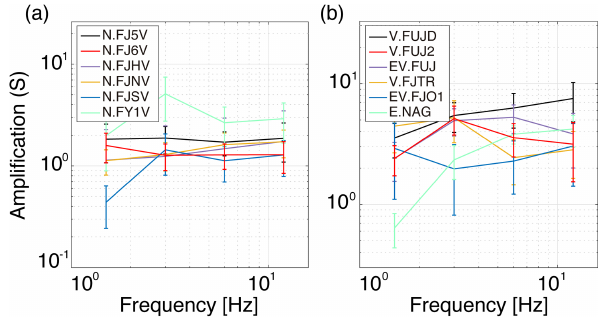
Figure 5. Site amplification factors ( S ) as a function of frequency estimated at the local network of Mt. Fuji, grouped by location: (a) borehole stations (NIED) and (b) surface stations (NU, ERI, and JMA). Table 3. Event number, start ( t 1 ) and end ( t 2 ) times of source lo- calization, spatial extent of the seismic locations ( D s ), maximum source amplitude ( A 0 ), and maximum radiated seismic energy ( E s ).